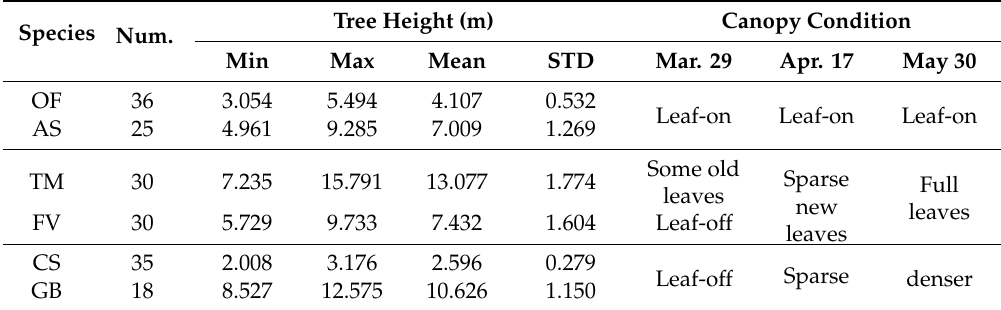
Table 1. Tree height statistics of six species and their leaf conditions during the three UAV campaign periods (March 29, April 17, and May 30). Tree Height (m) Species Num.